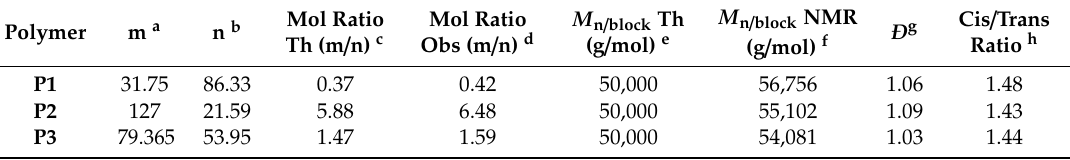
Table 1. Summary of the characterization of the block copolymers P1 , P2 , and P3